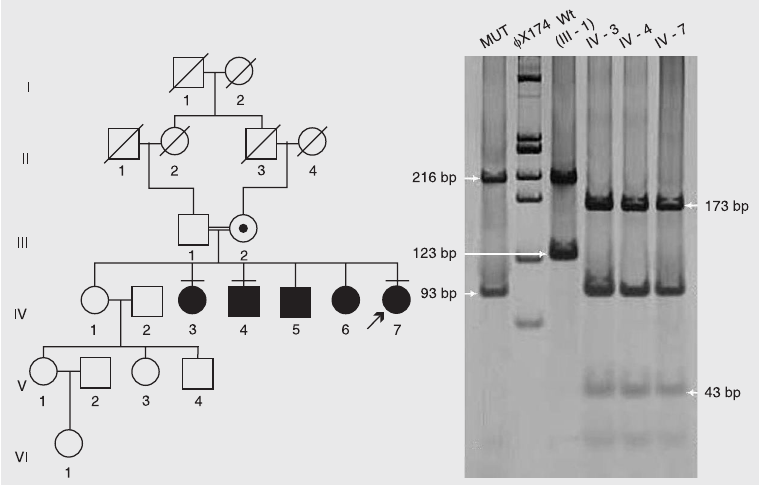
Figure 2. A , Pedigree of Family 3 with mtDNA A1555G and T1291C substitutions. Symbols are defined in Figure 1. B , Polyacrylamide gel electrophoresis (6%) with restriction patterns: MUT = the 216-, 93-bp fragments (the 30-bp fragment also found in A1555G carriers is not shown); WT (III-1) = the 216- and 123-bp bands from the wild-type father; IV-3, IV-4 and IV- 7 = carriers of both A1555G and T1291C substitutions. The restriction fragments (173 and 43 bp) generated when the T1291C substitution is present are indicated by arrows on the right. Figure 3. Pedigree of Family 4 with the mtDNA A1555G muta- tion. Symbols are defined in Fig- ure